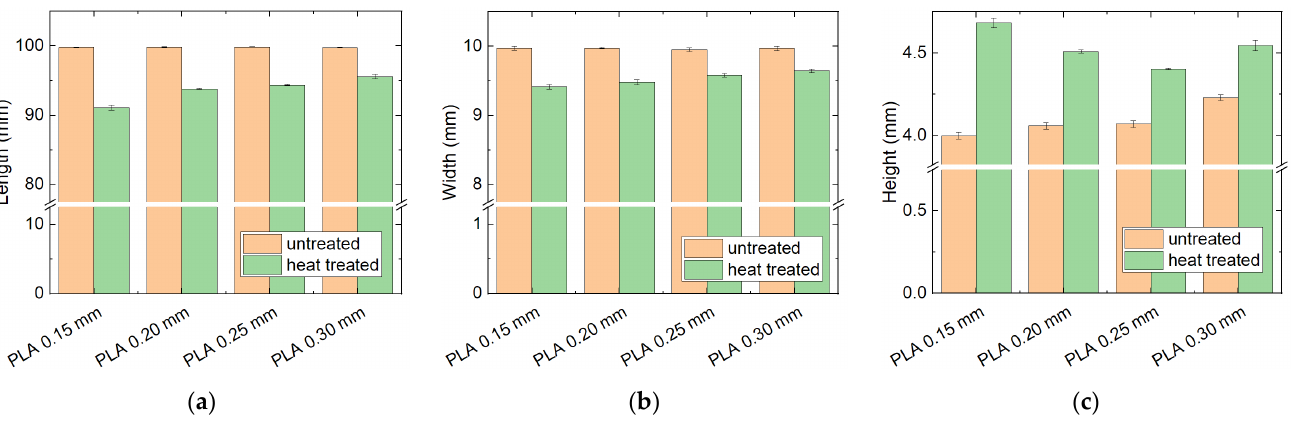
Figure 4. Dimensions of the heat-treated (100 °C) PLA samples with different layer heights: ( a ) length; ( b ) width; ( c ) height.